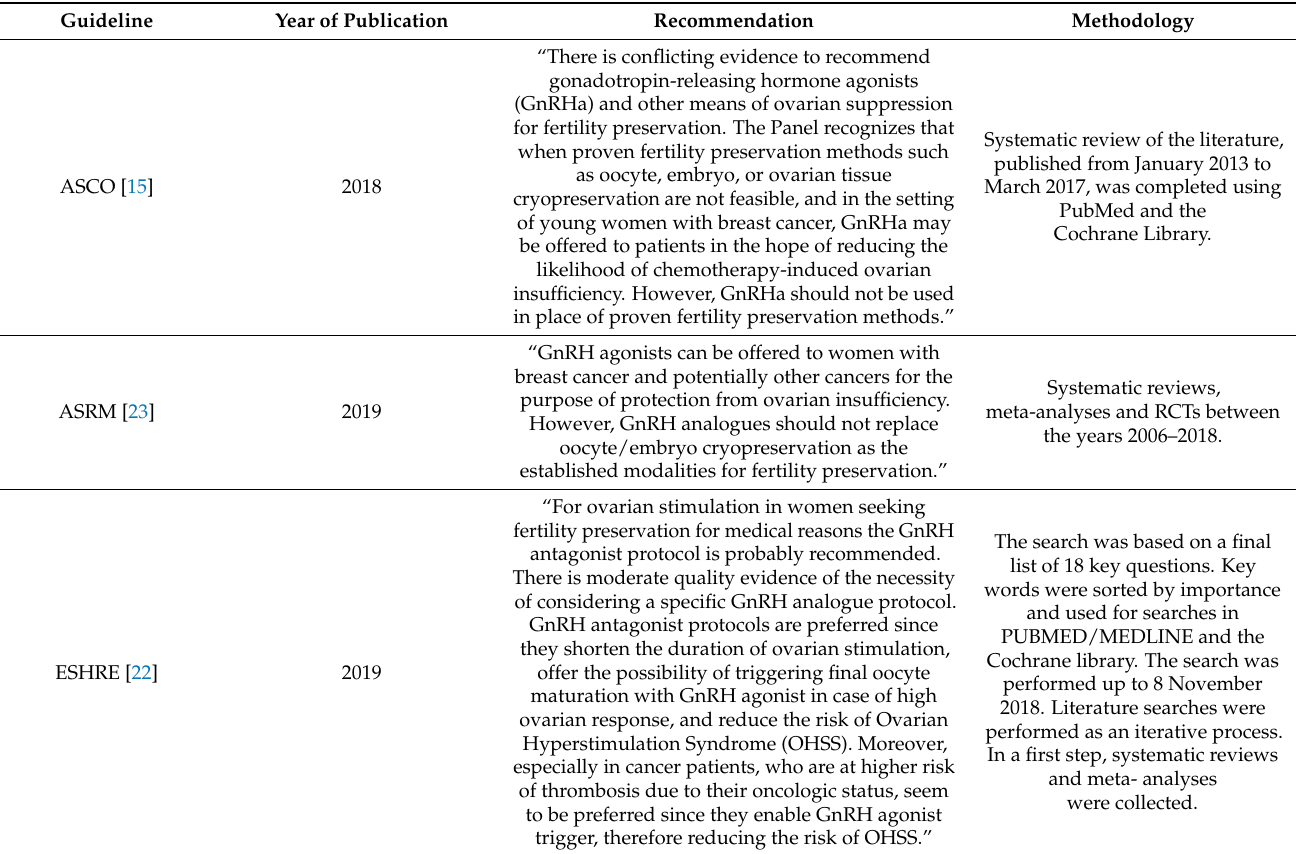
Table 1. International guidelines on GnRH